Question: Write a single sentence explaining what this figure depicts.
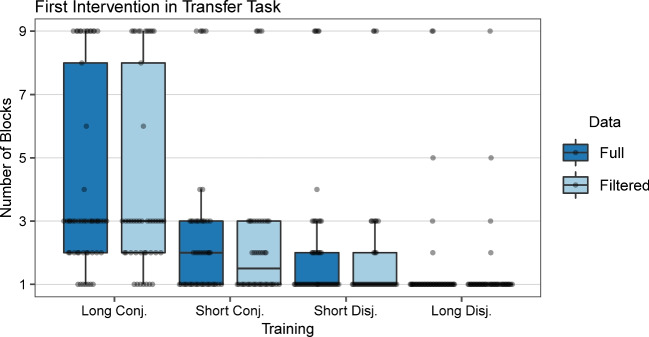
Answer: Experiment 1: Number of blocks in the first intervention in the transfer task. This is plotted against the functional form of past training tasks and the training length. The box-and-whisker plots show the quartiles of the full or filtered data; each overlaid point represents a participant